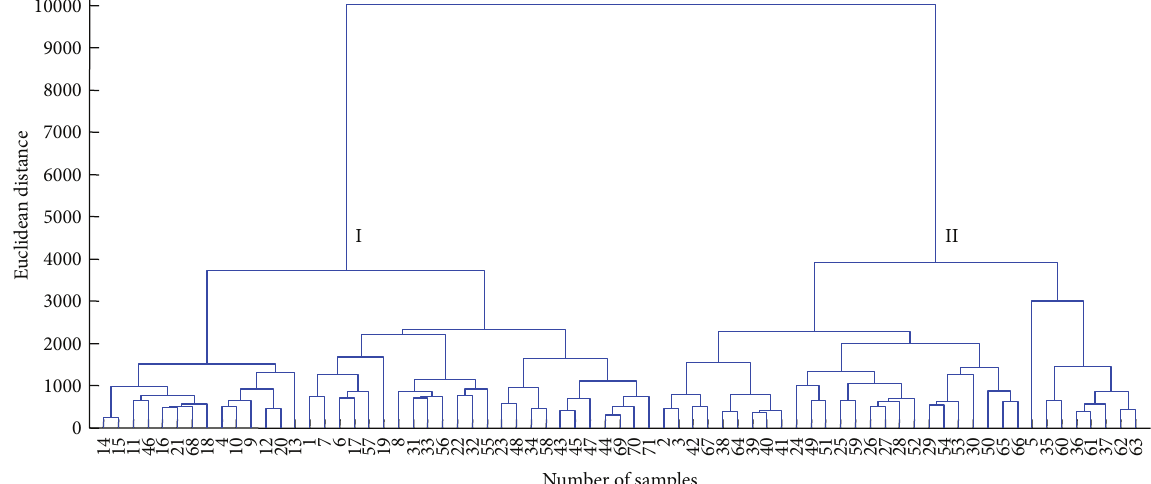
Figure 2: Dendrogram of hierarchical cluster analysis of different batches of XKS tablet samples using Ward’s method.